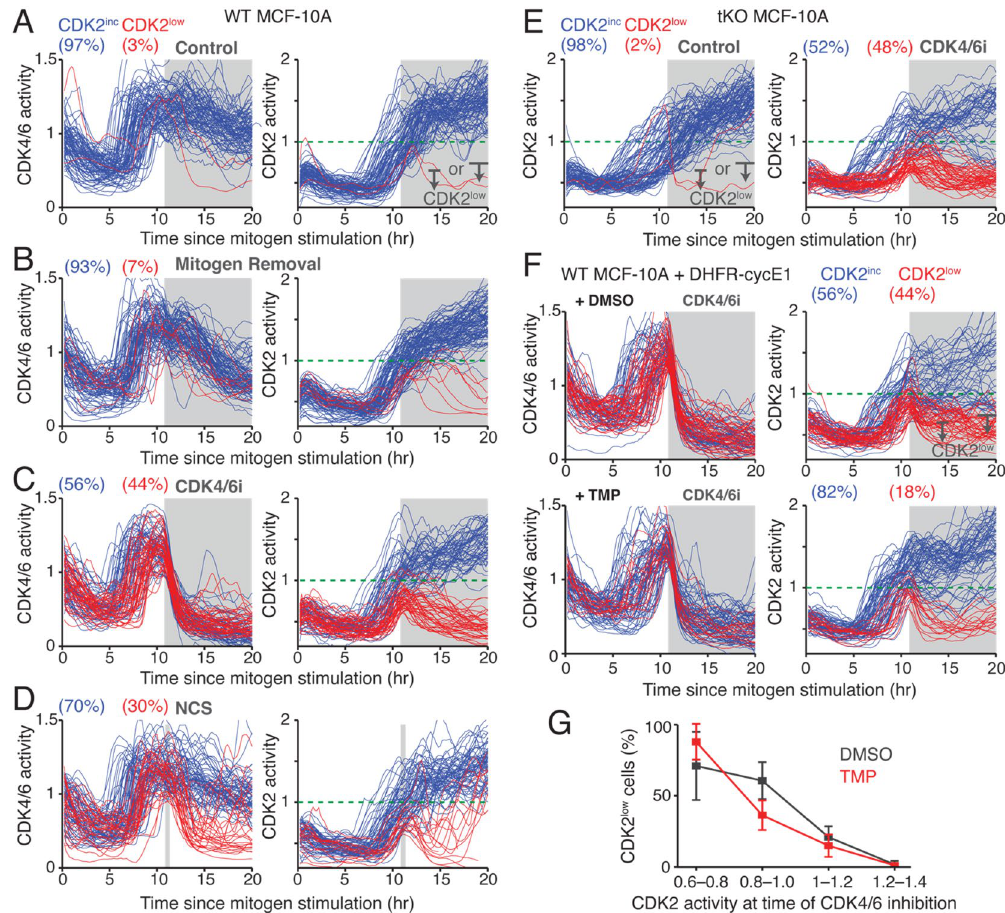
Figure 4. High CDK2 activity is required to initiate CDK4/6-independent cell cycle progression. ( A ‒ D ) Single-cell traces of CDK4/6 activity (left) and CDK2 activity (right) in wild type MCF-10A cells. Top to bottom, corresponding conditions under control ( A ), mitogen withdrawal ( B ), palbociclib (1 µM) ( C ), and 10 min NCS pulse (100 ng/ml) ( D ). All treatments performed 11 h after mitogen stimulation (marked in gray). Blue and red lines correspond to CDK2 inc and CDK2 low cells, respectively. Cells were classified based on CDK2 activity using 2 windows as indicated in ( A ). ( E ) Single-cell traces of CDK2 activity in p21/p27/p57 tKO MCF-10A cells. Control (left) and palbociclib (1 µM) (right) treatments were performed 11 h after mitogen stimulation (marked in gray). ( F , G ) Single-cell traces of CDK4/6 activity (left) and CDK2 activity (right) ( F ). Percentages of CDK2 low cells increasing CDK2 activity at the time of inhibition ( G ). After 48 h mitogen removal, MCF-10A cells expressing DHFR-cyclin E1 were stimulated with mitogens together with DMSO or TMP (50 µM). Palbociclib (1 µM) treatment were performed 11 h after mitogen stimulation. Data are mean ± s.d. ( n = 5 biological replicates) ( G